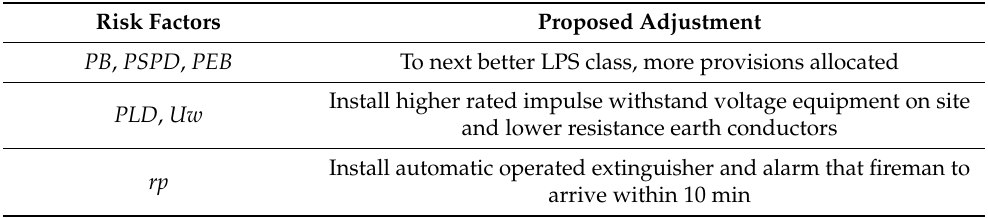
Table 17. Proposed Adjustment of Risk